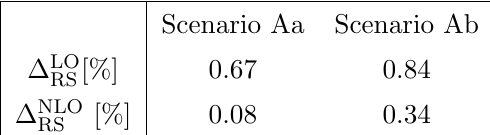
Table 4 . The variation (cid:1) RS of the h ! 4 f width using di(cid:11)erent renormalization schemes for input parameters de(cid:12)ned in the MS( (cid:21) 3 )